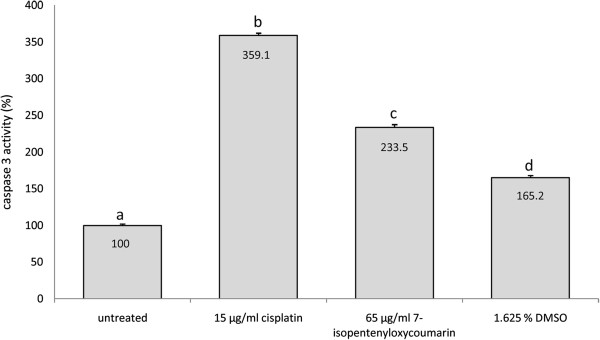
The effects of 7-IP on caspase-3 activity in 5637 cells as detected by colorimetric assay. 7-IP-treated cells show approximately 2.5 folds higher caspase activity than untreated cells. Cells treated with 15 μg/ml cisplatin showed elevated caspase-3 activity by approximately 3.5 folds. Data are expressed as mean ± SD. Results are from three independent experiments in triplicate. Distinct letters indicate significant differences (P < 0.001) between different groups.